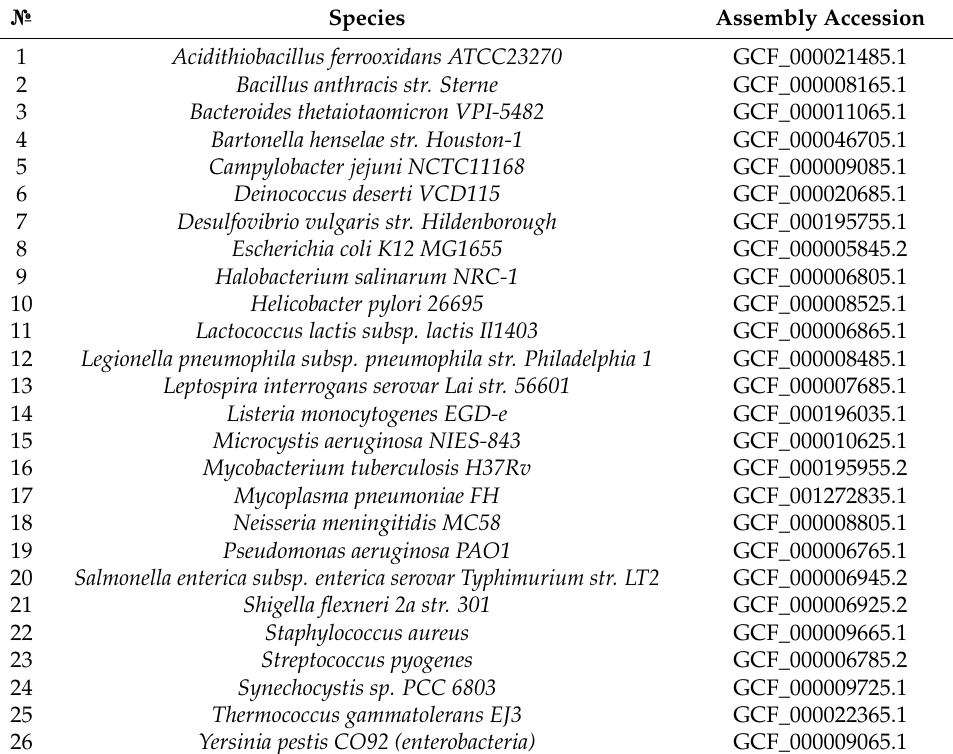
Table 2. The list of species under study (species for which proteomic data were collected) and corresponding assembly